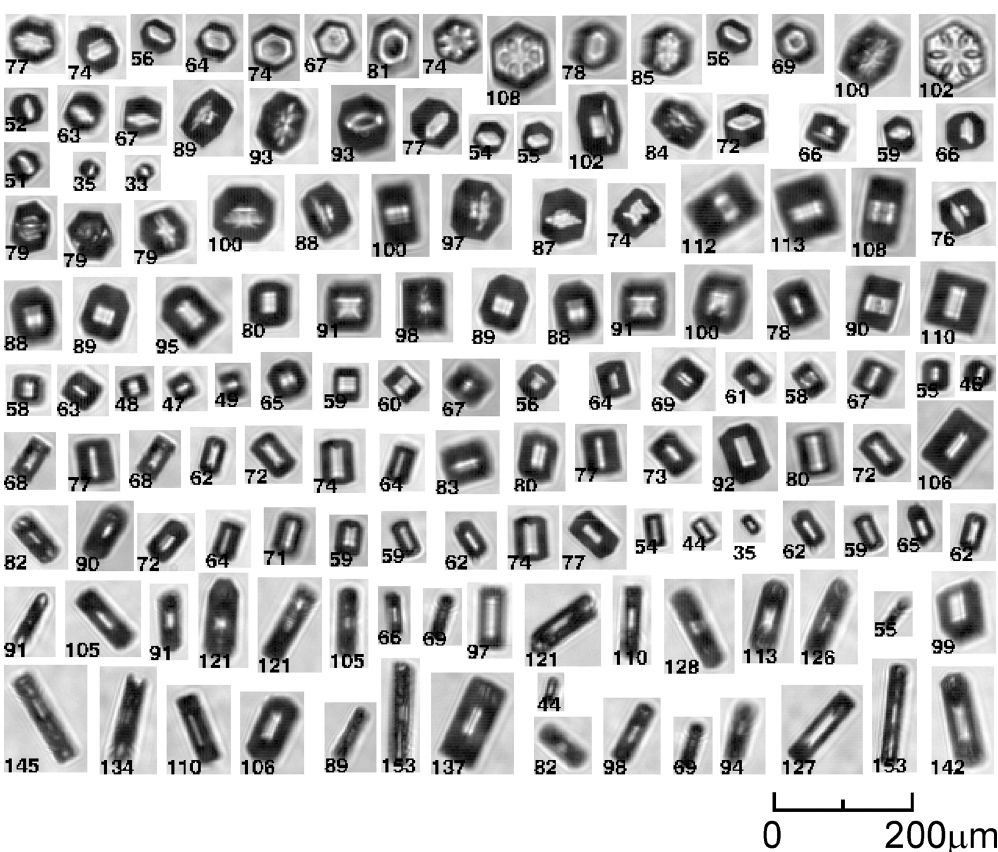
Figure 19. Images of small faceted ice particles, which were sampled in SIP cloud regions at − 5 . 5 ◦ C < T a < − 5 ◦ C, H = 5600m, indicated by grey color in Fig. 5. The aspect ratio of the small hexagonal prisms varies in the range of 0 . 3 < R <